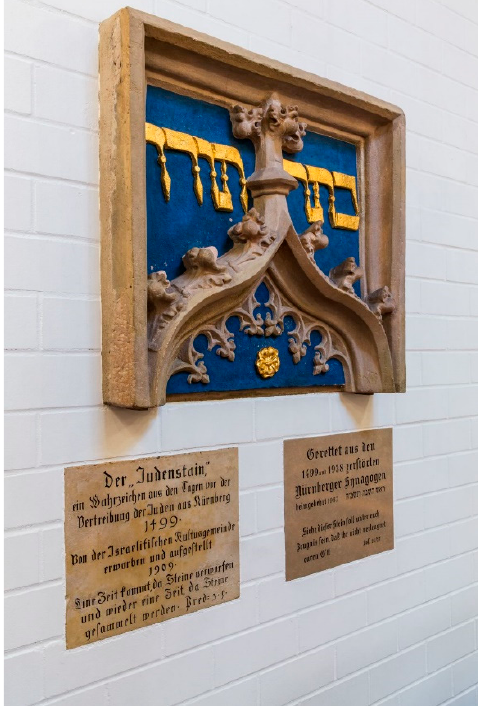
Figure 12. Nürnberg (Israelitische Kultusgemeinde Nürnberg, used with permission).